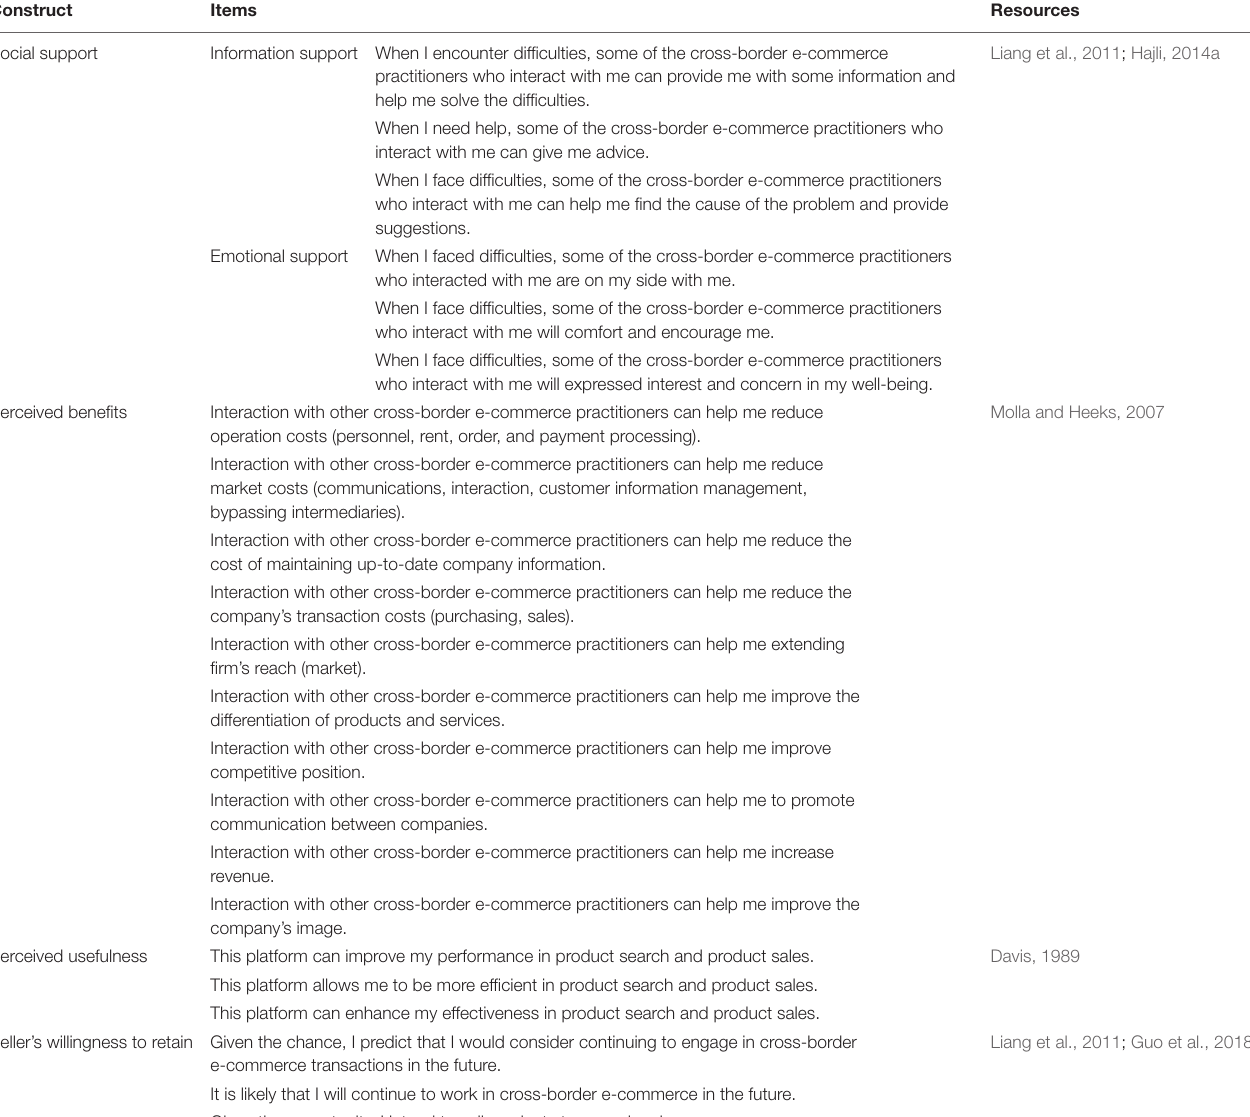
TABLE 2 | Scales of the